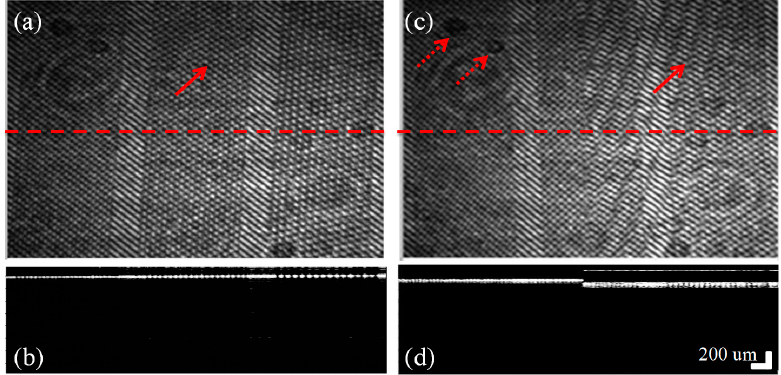
Figure 5. Tomographic images of the full-field OCT system. ( a , c ) Raw enface images of the Edmund optics target and the Edmund optics target with a 170- µ m-thick cover slip, respectively. ( b , d ) Cross-sectional images, clearly distinguishing the line separations along the dashed lines in ( a , c ), respectively. The solid arrow in ( a ) shows the interference fringe because of the reference mirror and the resolution target, while in ( c ) the arrow indicates the fringe pattern owing to the cover slip, reference mirror, and resolution target. The dotted arrow shows the background noise on the sample.